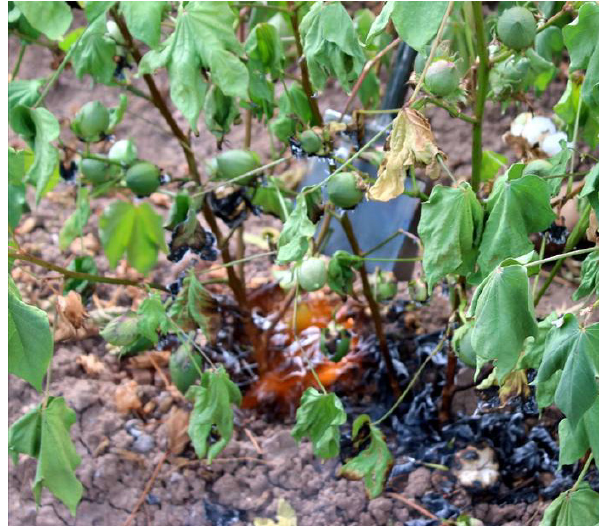
Figure 2. Flame girdling of field ‐ grown cotton plants.